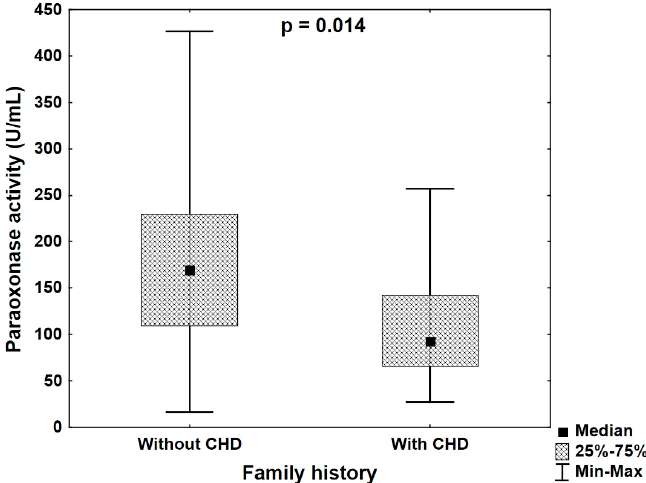
Figure 2. Paraoxonase activity in the groups of patients without coronary heart disease (CHD) in family history and with coronary heart disease in family history (Mann–Whitney U test).